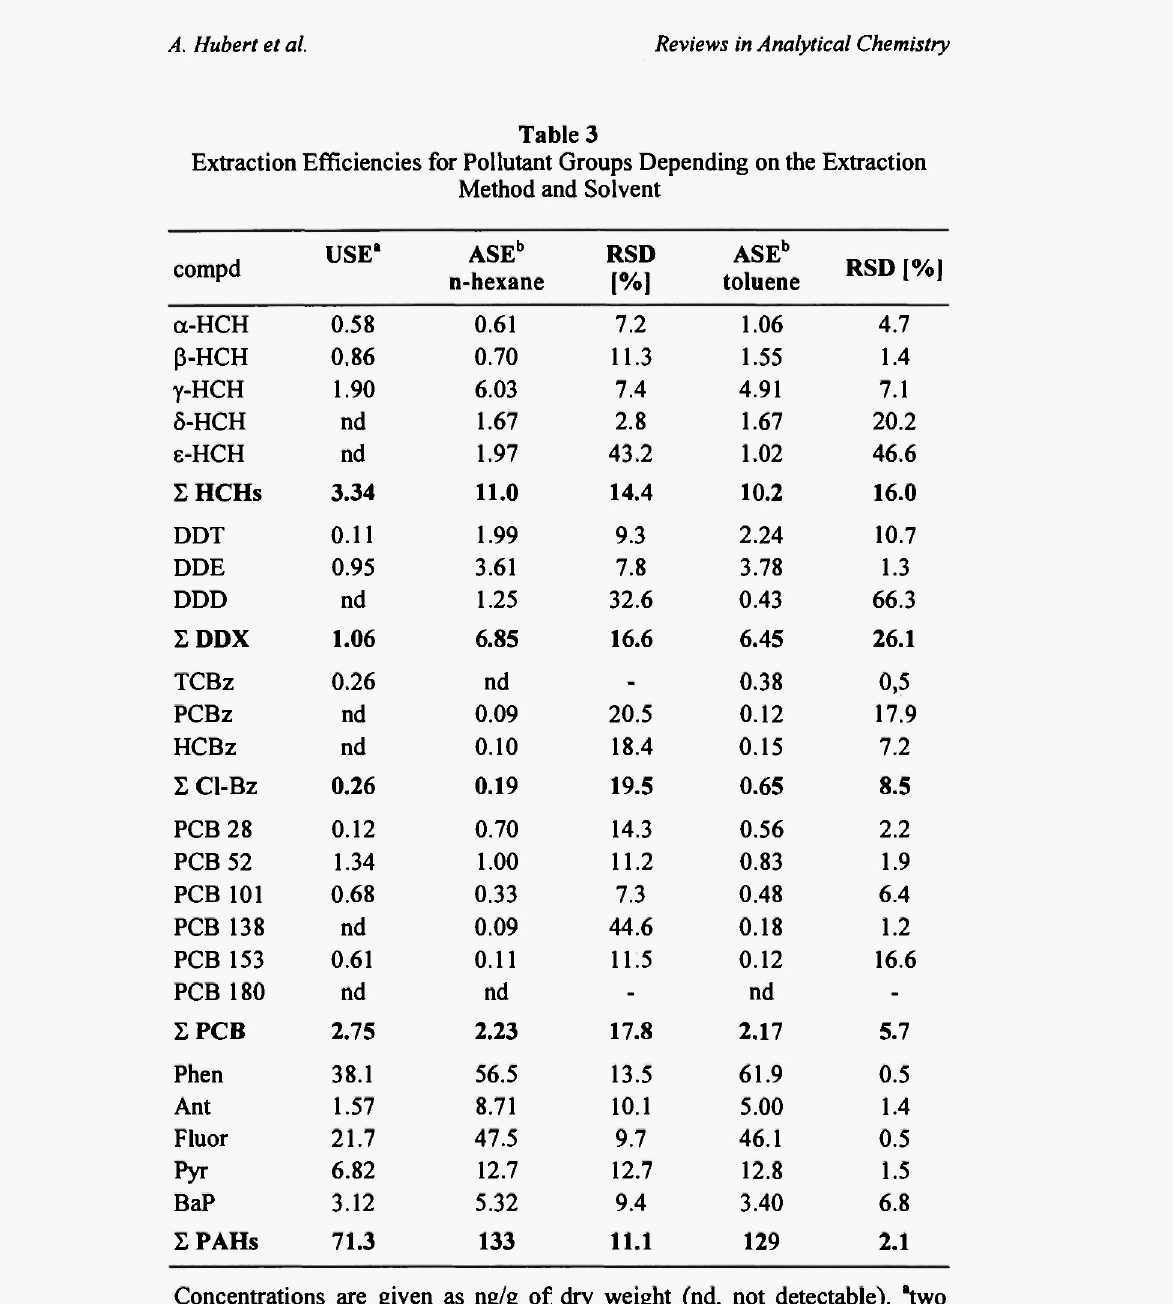
Extraction Efficiencies for Pollutant Groups Depending on the Extraction Method and